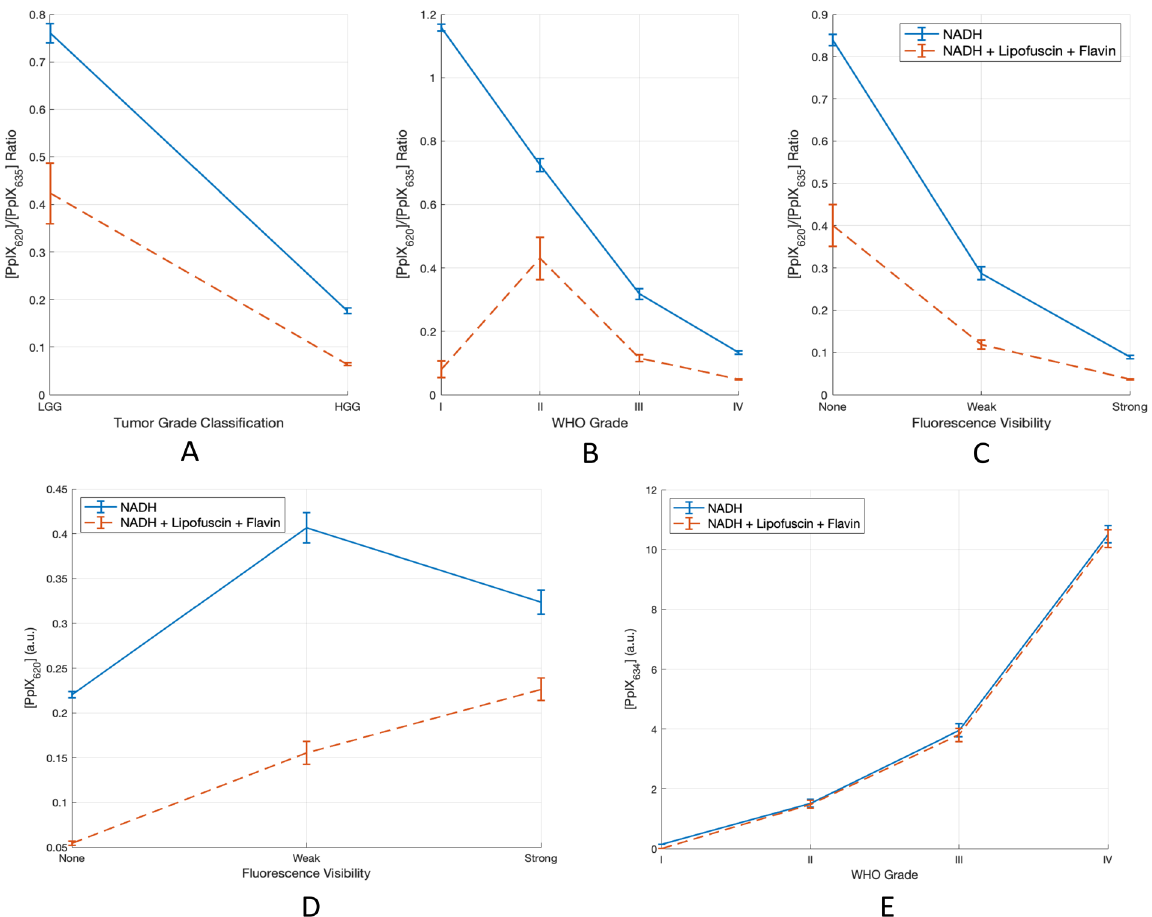
Figure 4. ( A , B , C ) Ratio 620/634 , ( D ) [PpIX 620 ], and ( E ) [PpIX 634 ] vs. WHO Grade and fluorescence visibility, using unmixing with only NADH and PpIX, and with all five basis spectra. The results from using only NADH show greatly inflated [PpIX 620 ], and thus artificially high Ratio 620/634